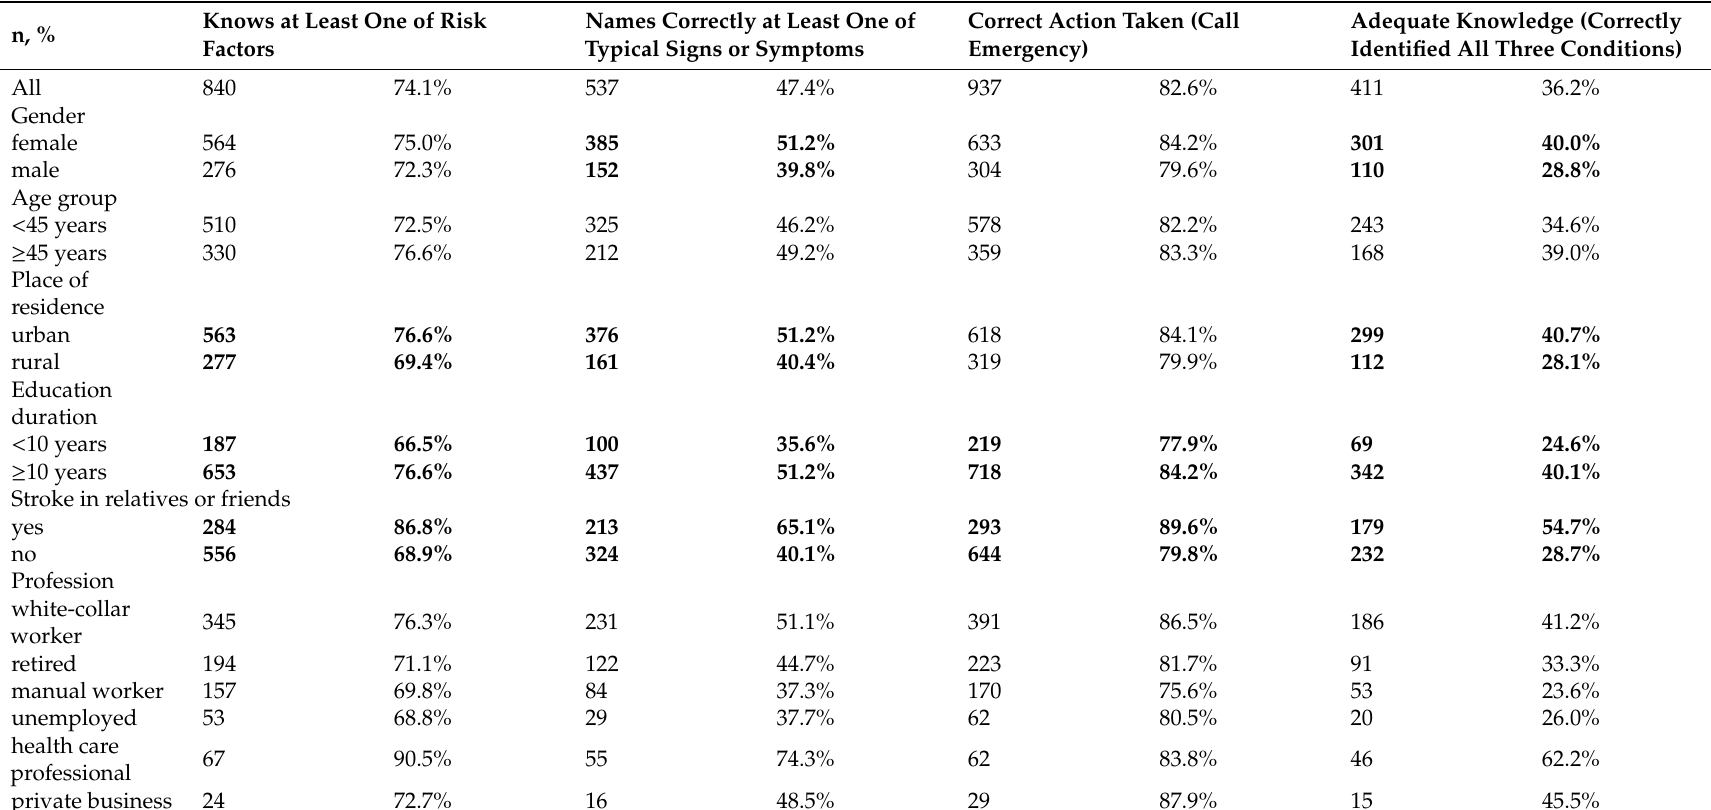
Table 6. Adequate knowledge of stroke as a combined measure of correct knowledge of risk factors, symptoms and necessary actions by gender, age group, place of residence, education level, and